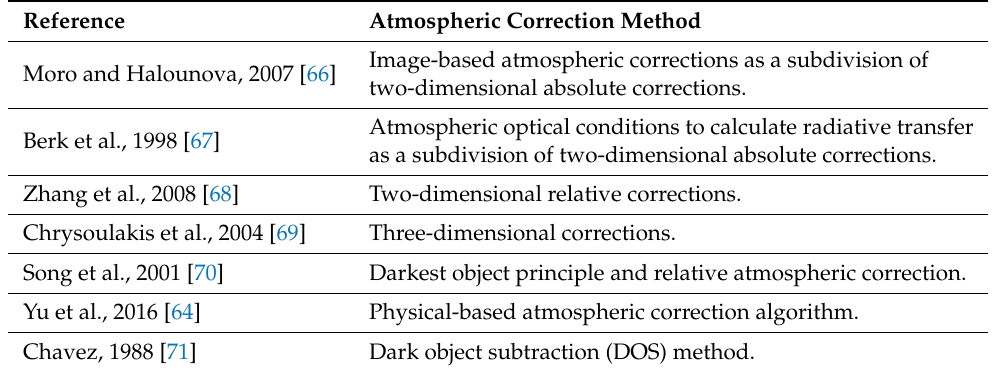
Table 6. Studies and methods applied for atmospheric correction in